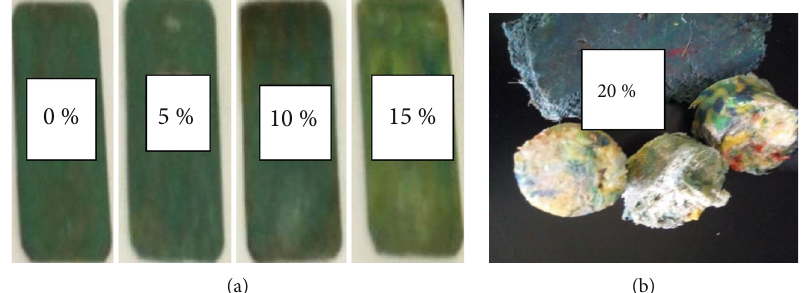
Figure 4: Sisal fi ber-reinforced polypropylene composite: (a) 0-15% fi ber content and (b) 20% fi ber content.